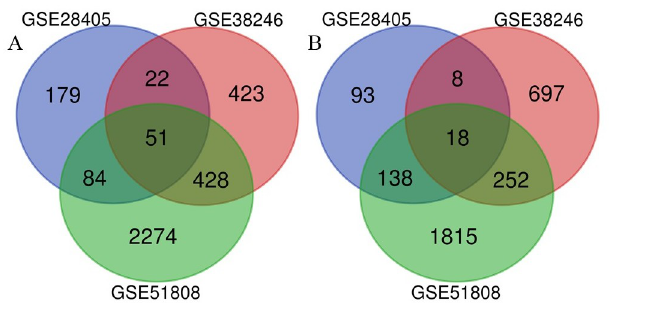
Fig 2. The intersection results of GSE28405, GSE38246, and GSE51808.